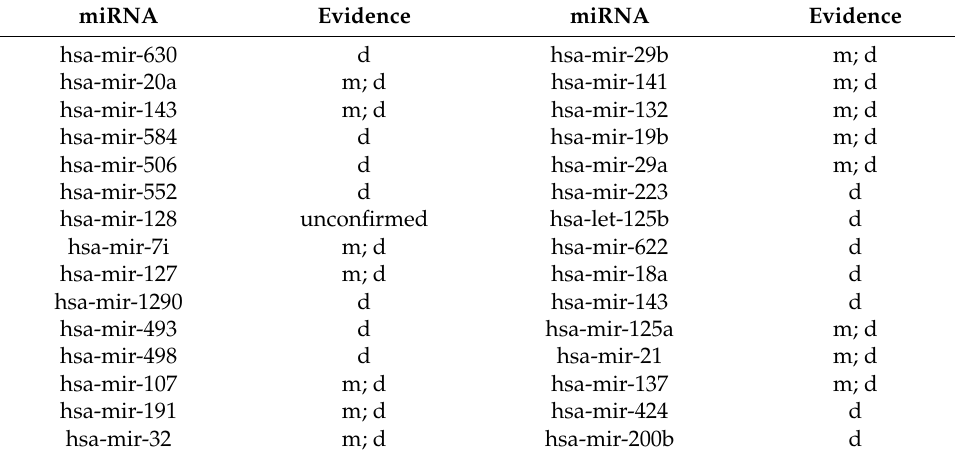
Table 1. The top 30 potential miRNAs associated with colon neoplasms. miRNA Evidence miRNA Evidence hsa-mir-630